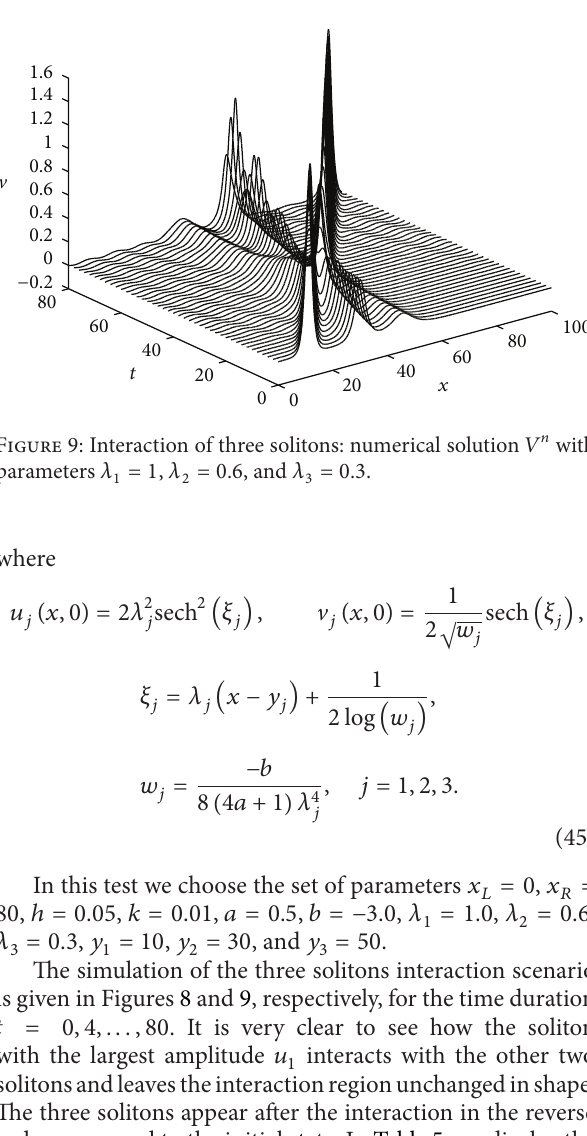
Figure 8: Interaction of three solitons: numerical solution 𝑈 𝑛 with parameters 𝜆 1 = 1 , 𝜆 2 = 0.6 , and 𝜆 3 = 0.3 .